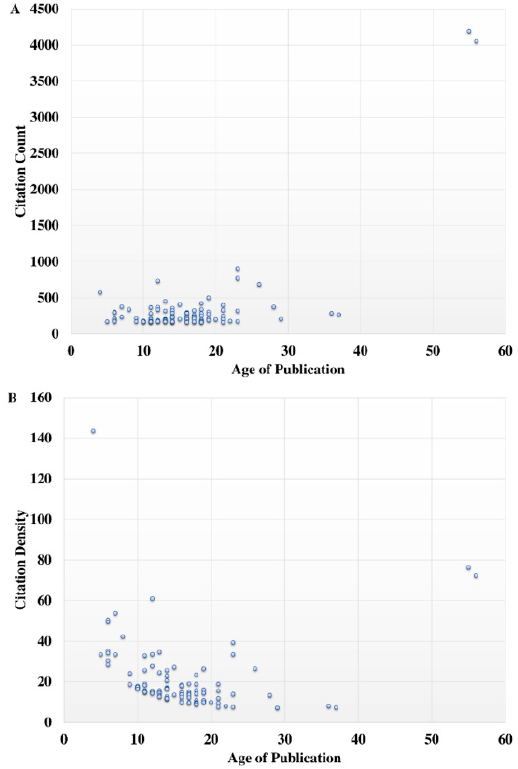
Figure 1. Association of ( A ) citation count and ( B ) citation density with age of publication.